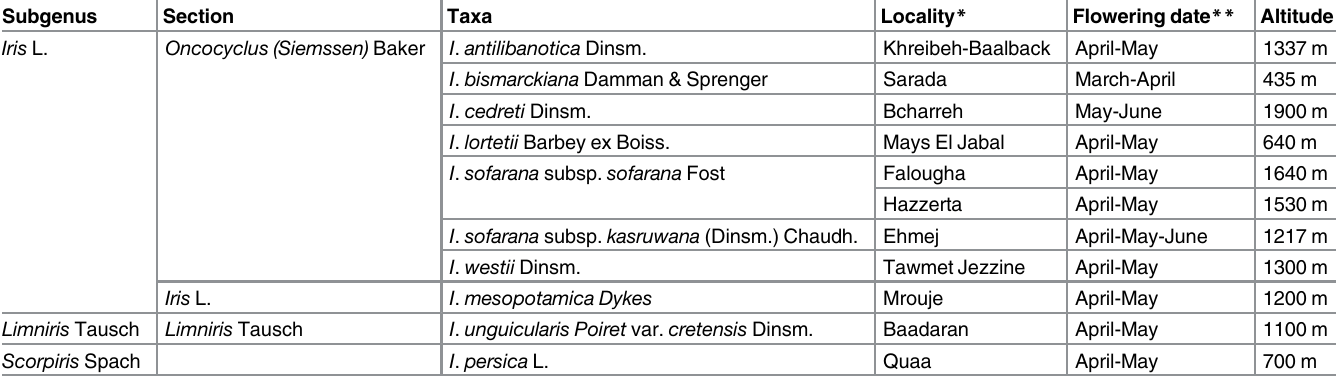
Table 1. Geographical origin (locality and altitude) and flowering date of the investigated